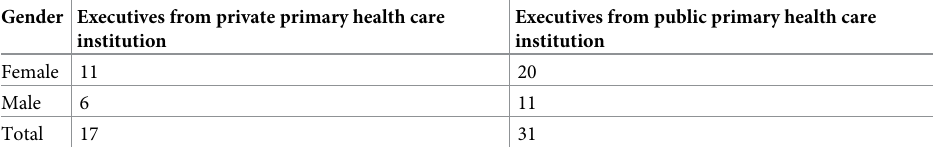
Fig 1. The methodology of the study. https://doi.org/10.1371/journal.pone.0209816.g001 Table 1. Profile of